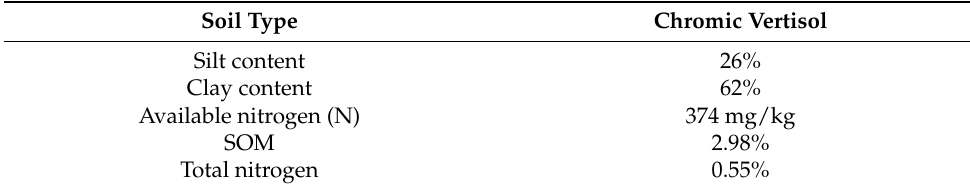
Figure 1. Map showing the study area. Table 1. Initial soil conditions measured prior to the start of greenhouse gas measurements.